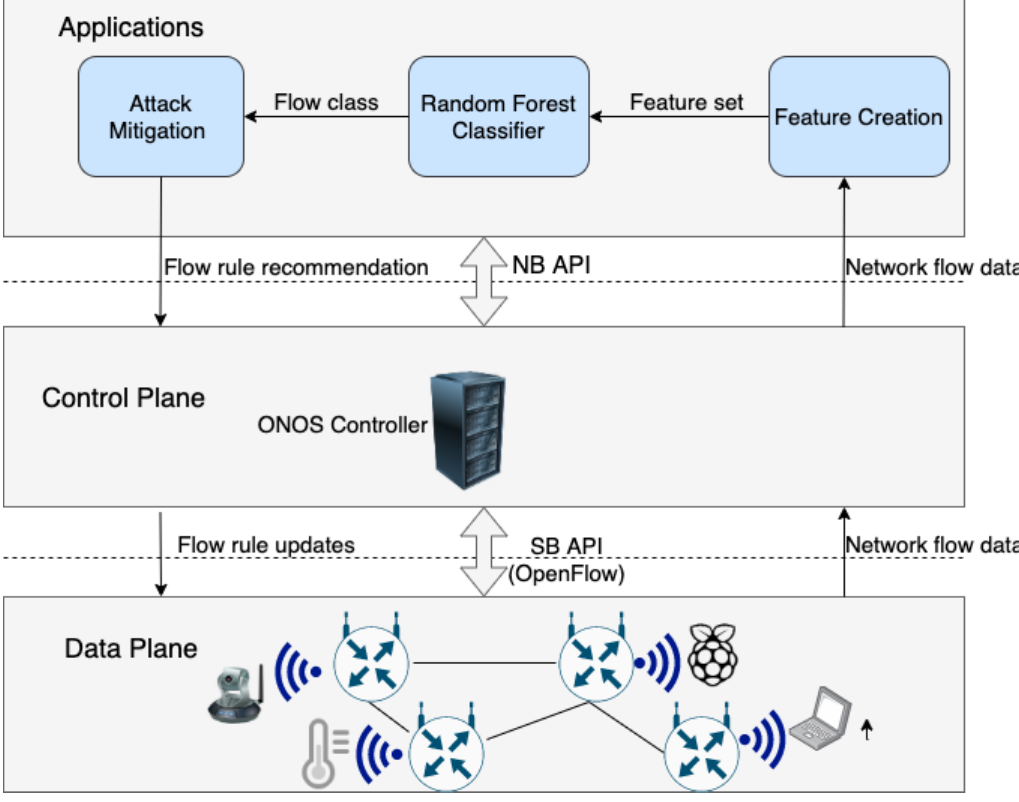
Figure 6. SDN-based Security Solution